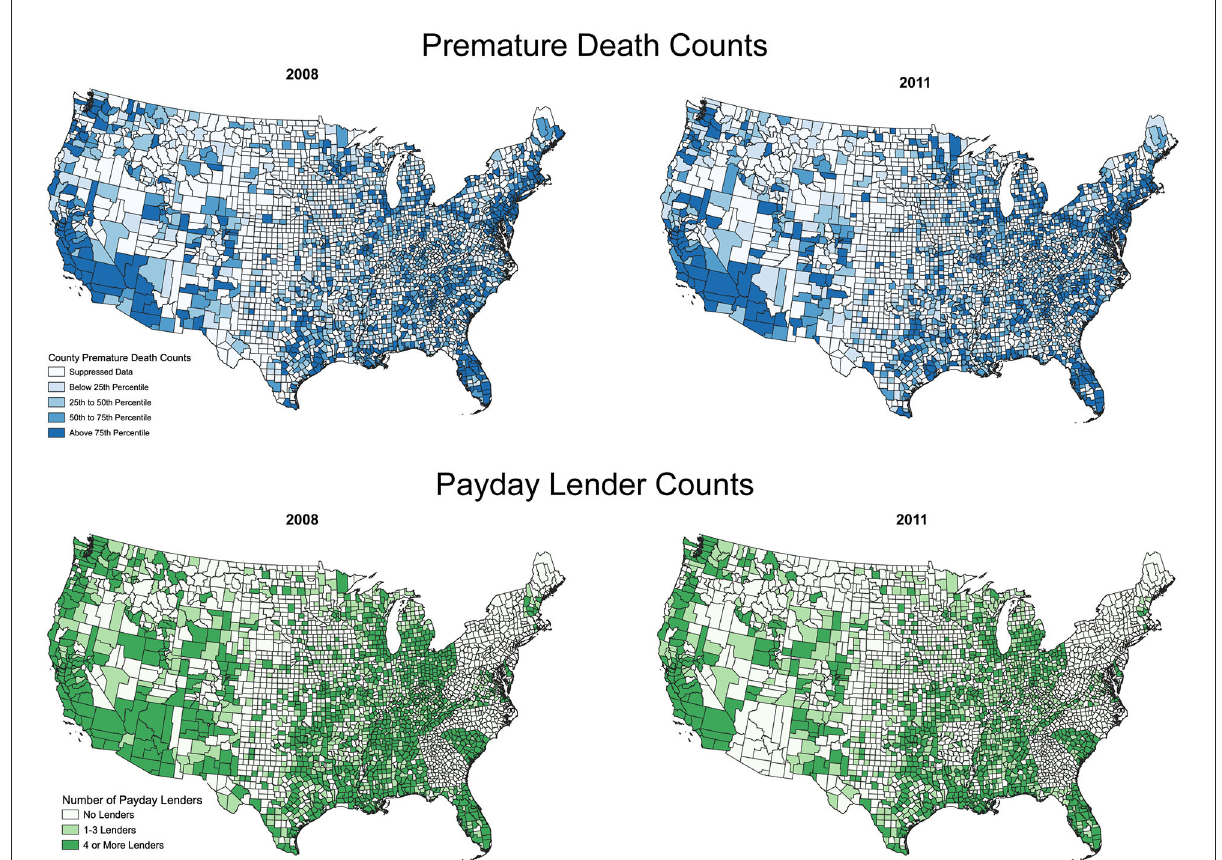
FIGURE1 Counts of premature deaths and payday lenders over time (by county and year) for counties in the continental United States. Maps created using QGIS software, county boundaries reflect 2010 Census